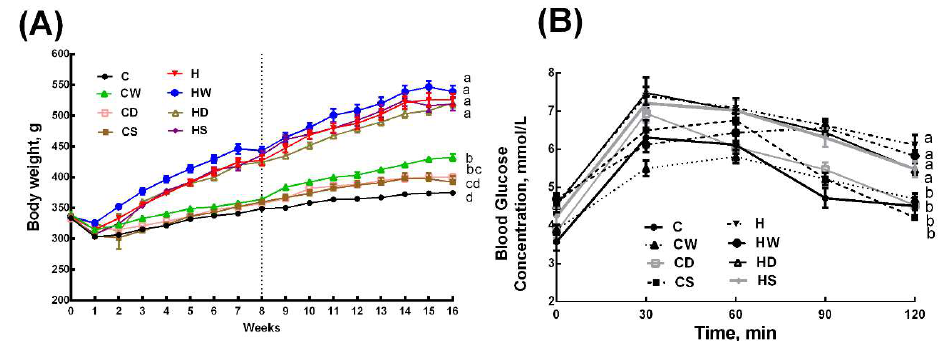
Figure 1. Effects of whole linseed, defatted linseed, and secoisolariciresinol diglucoside (SDG) on ( A ) body weight and ( B ) oral glucose tolerance test. The vertical dotted grid line in ( A ) at week 8 represents the start of treatment for rats. Data are presented as mean ± SEM, n = 10–12. End-point means with different letters (a, b, c, or d) are significantly different, p < 0.05. C, corn starch diet-fed rats; CW, corn starch diet-fed rats treated with whole linseed; CD, corn starch diet-fed rats treated with defatted linseed; CS, corn starch diet-fed rats treated with SDG; H, high-carbohydrate, high-fat diet-fed rats; HW, high-carbohydrate, high-fat diet-fed rats treated with whole linseed; HD, high-carbohydrate, high-fat diet-fed rats treated with defatted linseed; HS, high-carbohydrate, high-fat diet-fed rats treated with SDG.